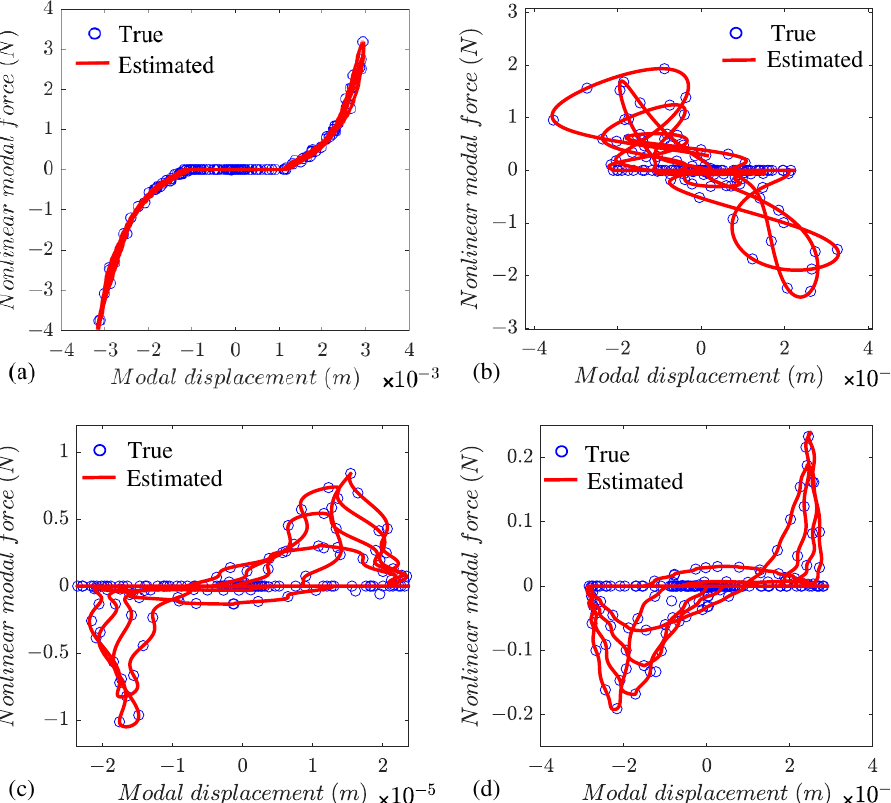
Figure 9. Nonlinear modal force-displacement responses fitted based on LM optimisation algorithm ( a ) mode 1, ( b ) mode 2, ( c ) mode 3, ( d ) mode